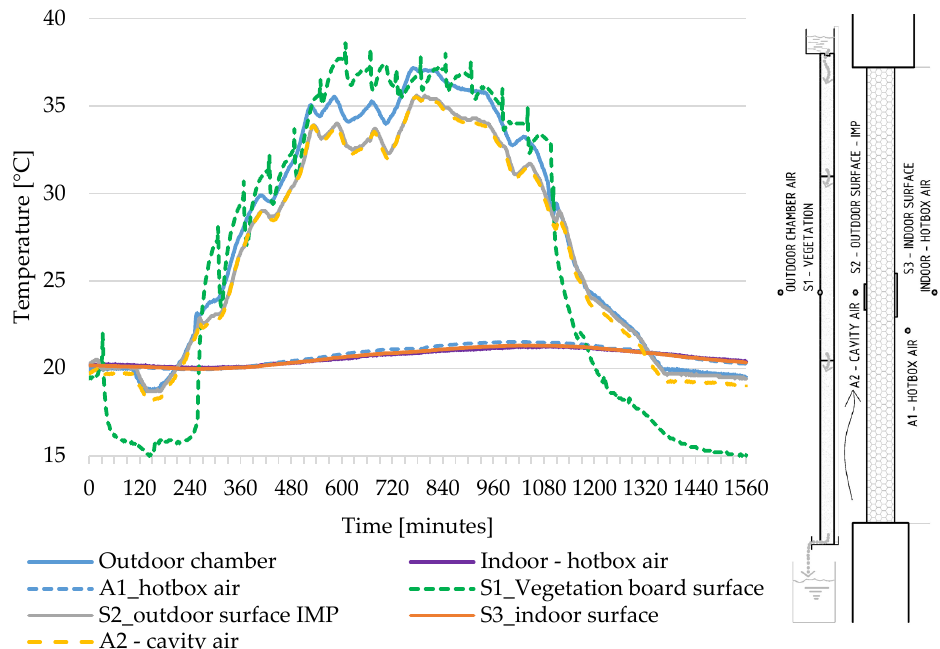
Figure 8. The temperature course for the setup with the vegetation board, sun simulation on, and hourly watering. Increase in S3 indoor surface temperature from 20.0 to 21.7 °C (temperature difference ∆ θ si = 1.7 K).